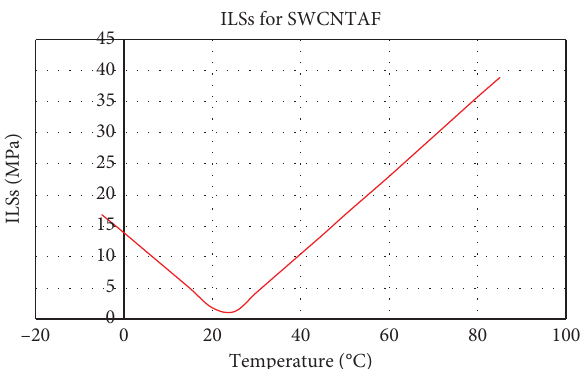
Figure 3: ILSs over the interfaces between SWCNT and AF at temperature range of − 5 to 85 ° C within the SWCNTAF.